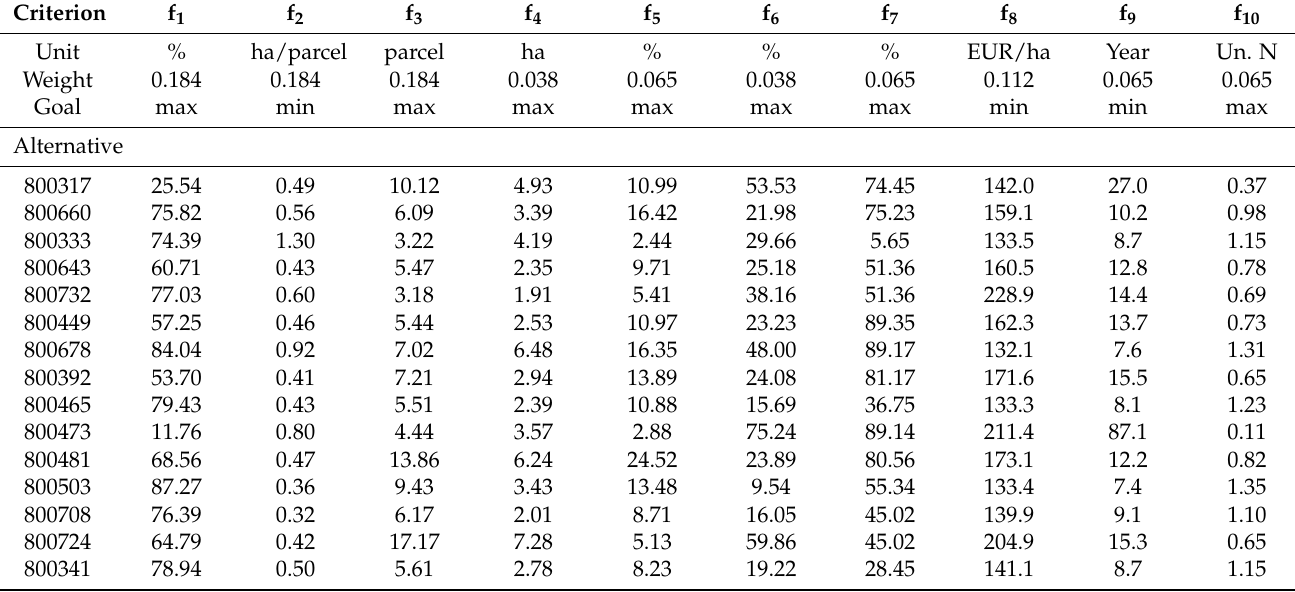
Table 7. Decision-making matrix case for ten criteria